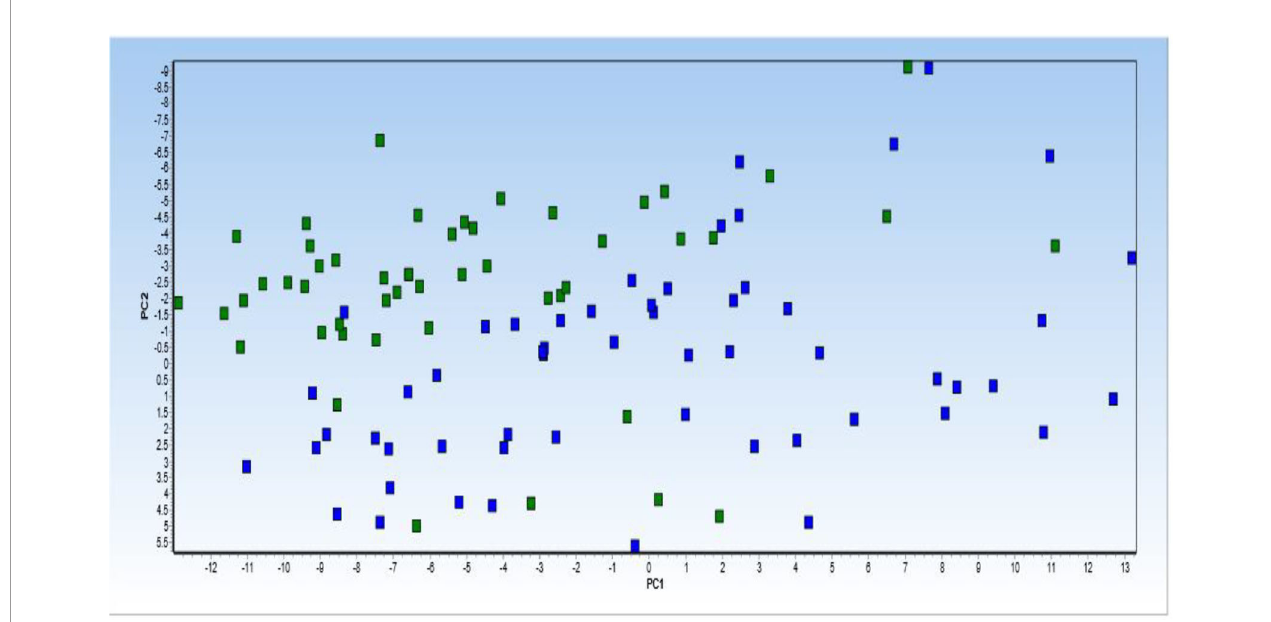
FIGURE 5 | Principal component analysis (PCA) of 6 lncRNA expression pro fi les in patients with Parkinson diseases compared with healthy control. PCA of the 6 lncRNAs expression data could not clearly clusters samples collected from healthy controls (blue squares) and patients with Parkinson (green squares) into their respective groups. Normalized values were used for principal component analysis.